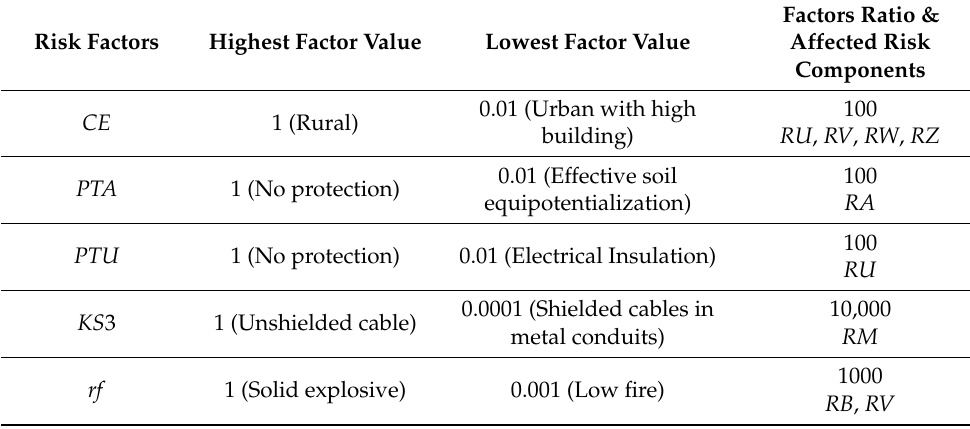
Table 11. Major Significant Range of Risk Factors.